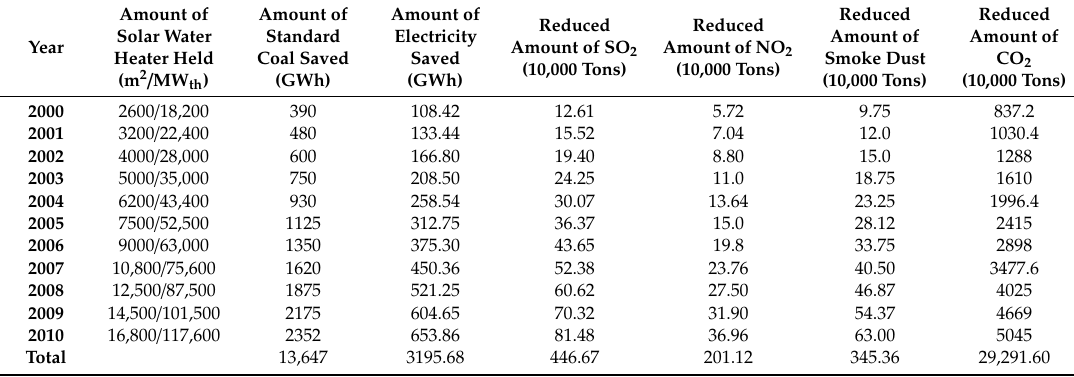
Table 5. Amount of energy saved and amount of emissions reduced by using solar water heaters between 2000 and 2010.